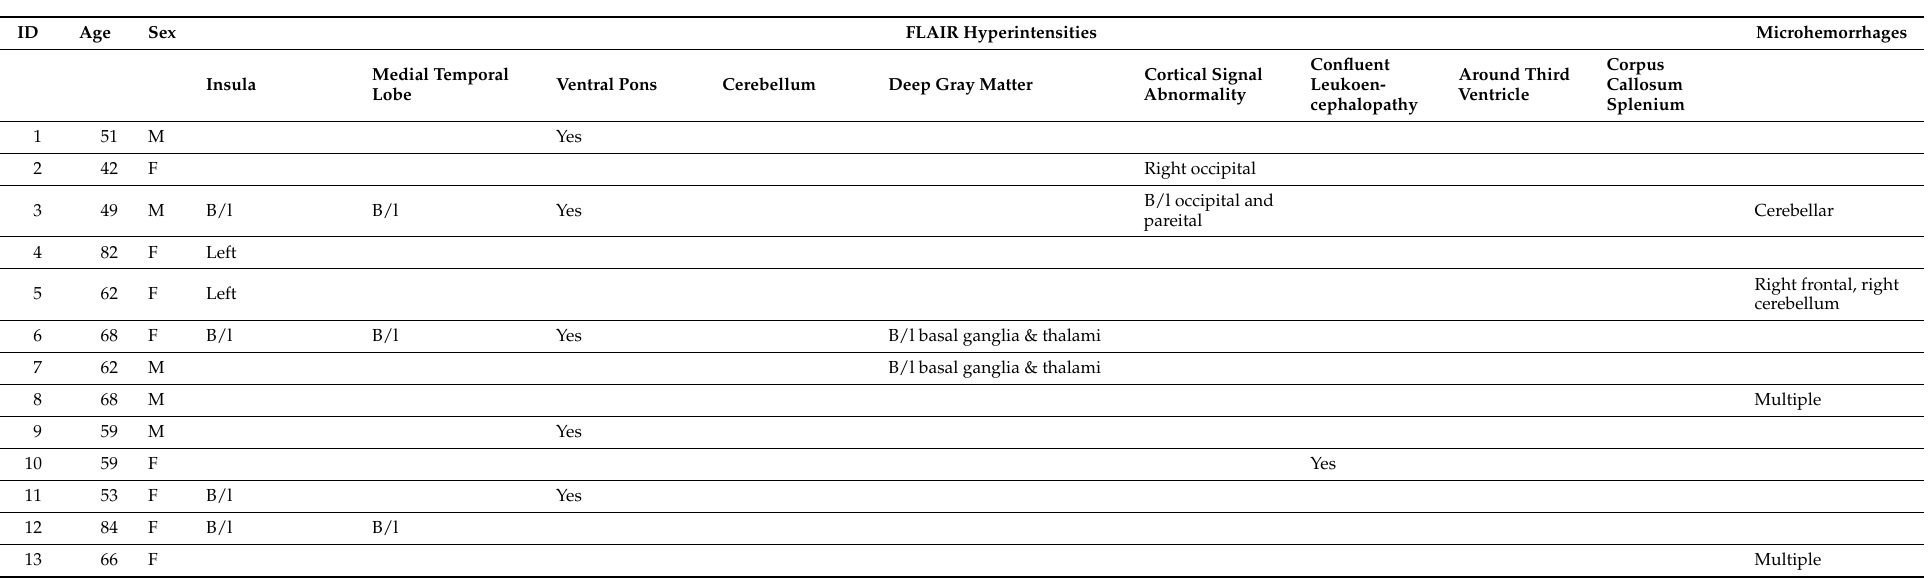
Table 3. Imaging Characteristics of the